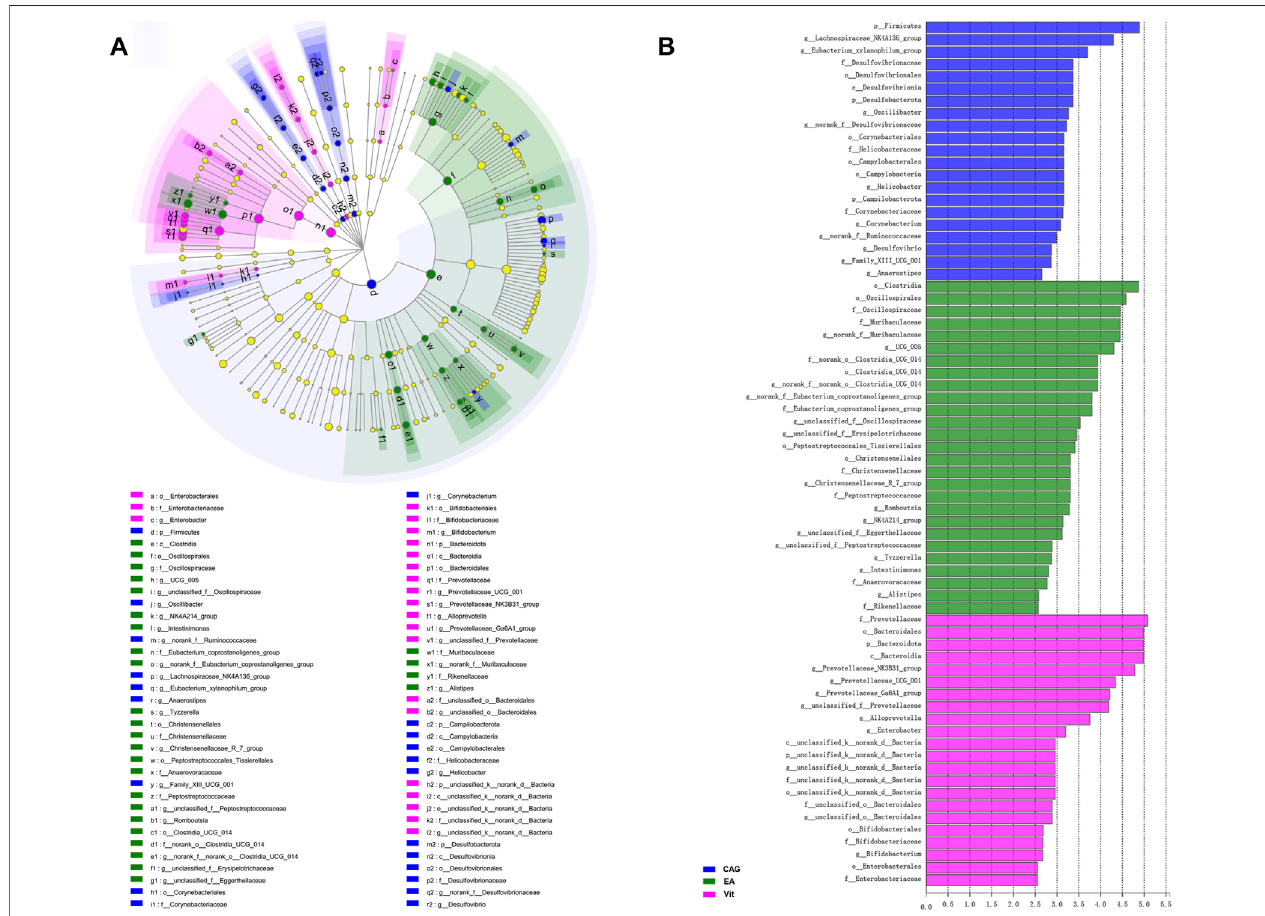
FIGURE 7 | LEfSe analysis of rat intestinal microbiota in the CAG, EA, and Vit groups. (A) LEfSe multilevel species tree diagram. (B) LDA discriminant bar